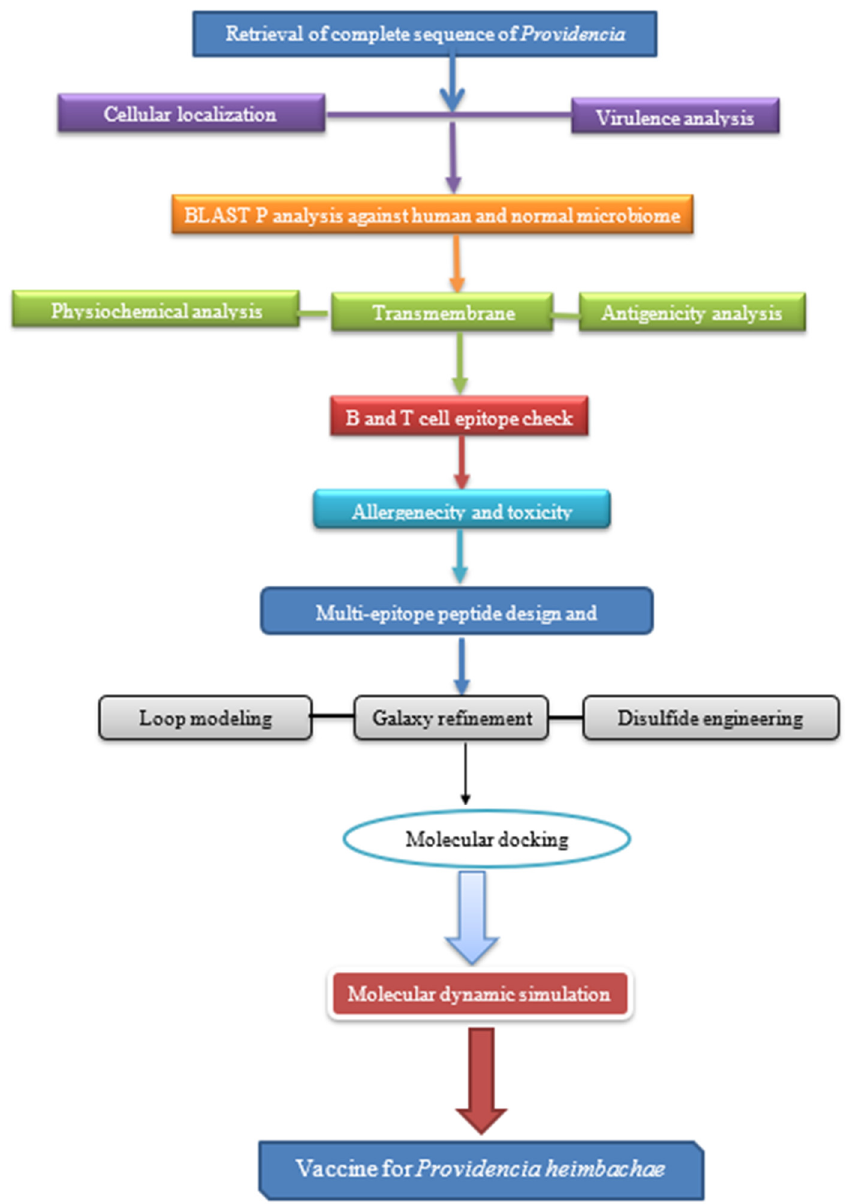
Figure 1. Stepwise representation of the complete method followed in this study. This method starts with proteomic sequence retrieval and finishes with peptide-based vaccine, followed by epitope prediction, secondary and tertiary structure prediction, refining molecular docking, and immune stimulation .